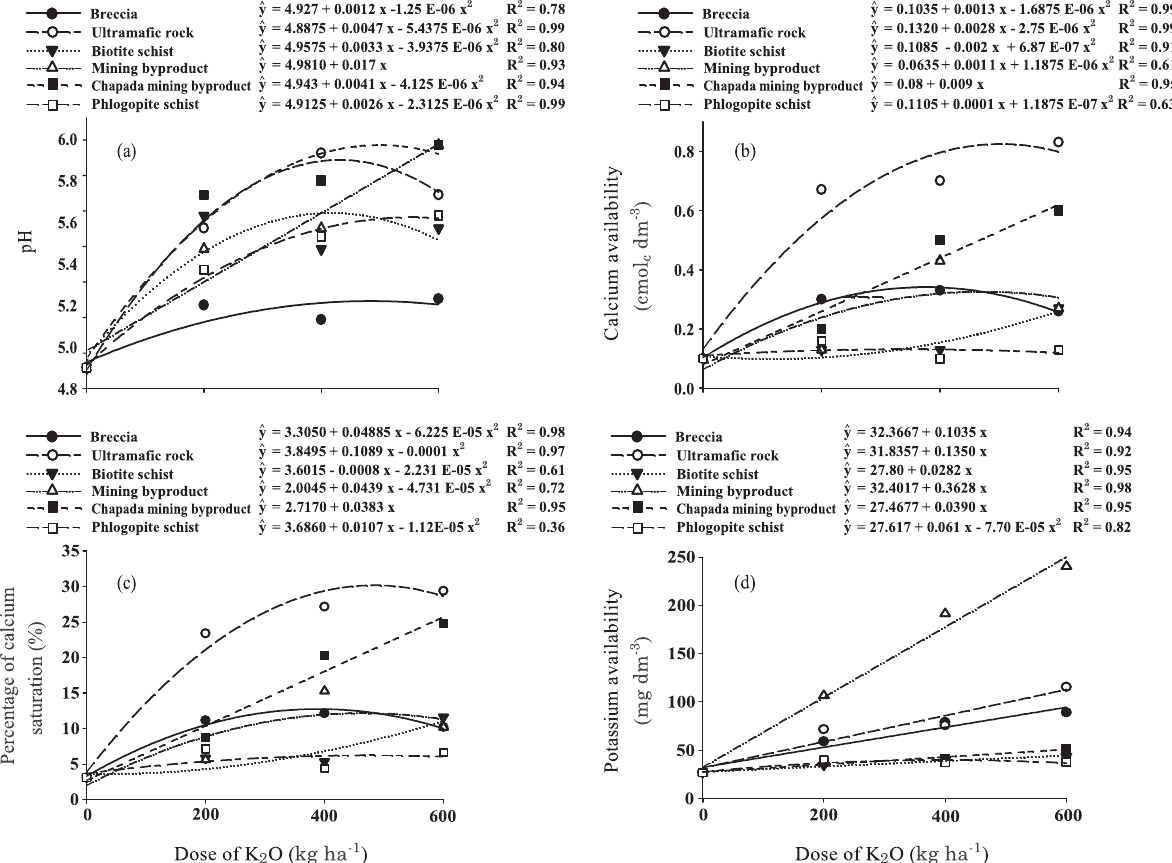
figure 2. soil ph (a), Ca availability (b), Ca saturation (c), k availability (d) for breccia, ultramafic rock, biotite schist, mining byproduct, Chapada mining byproduct and phlogopite